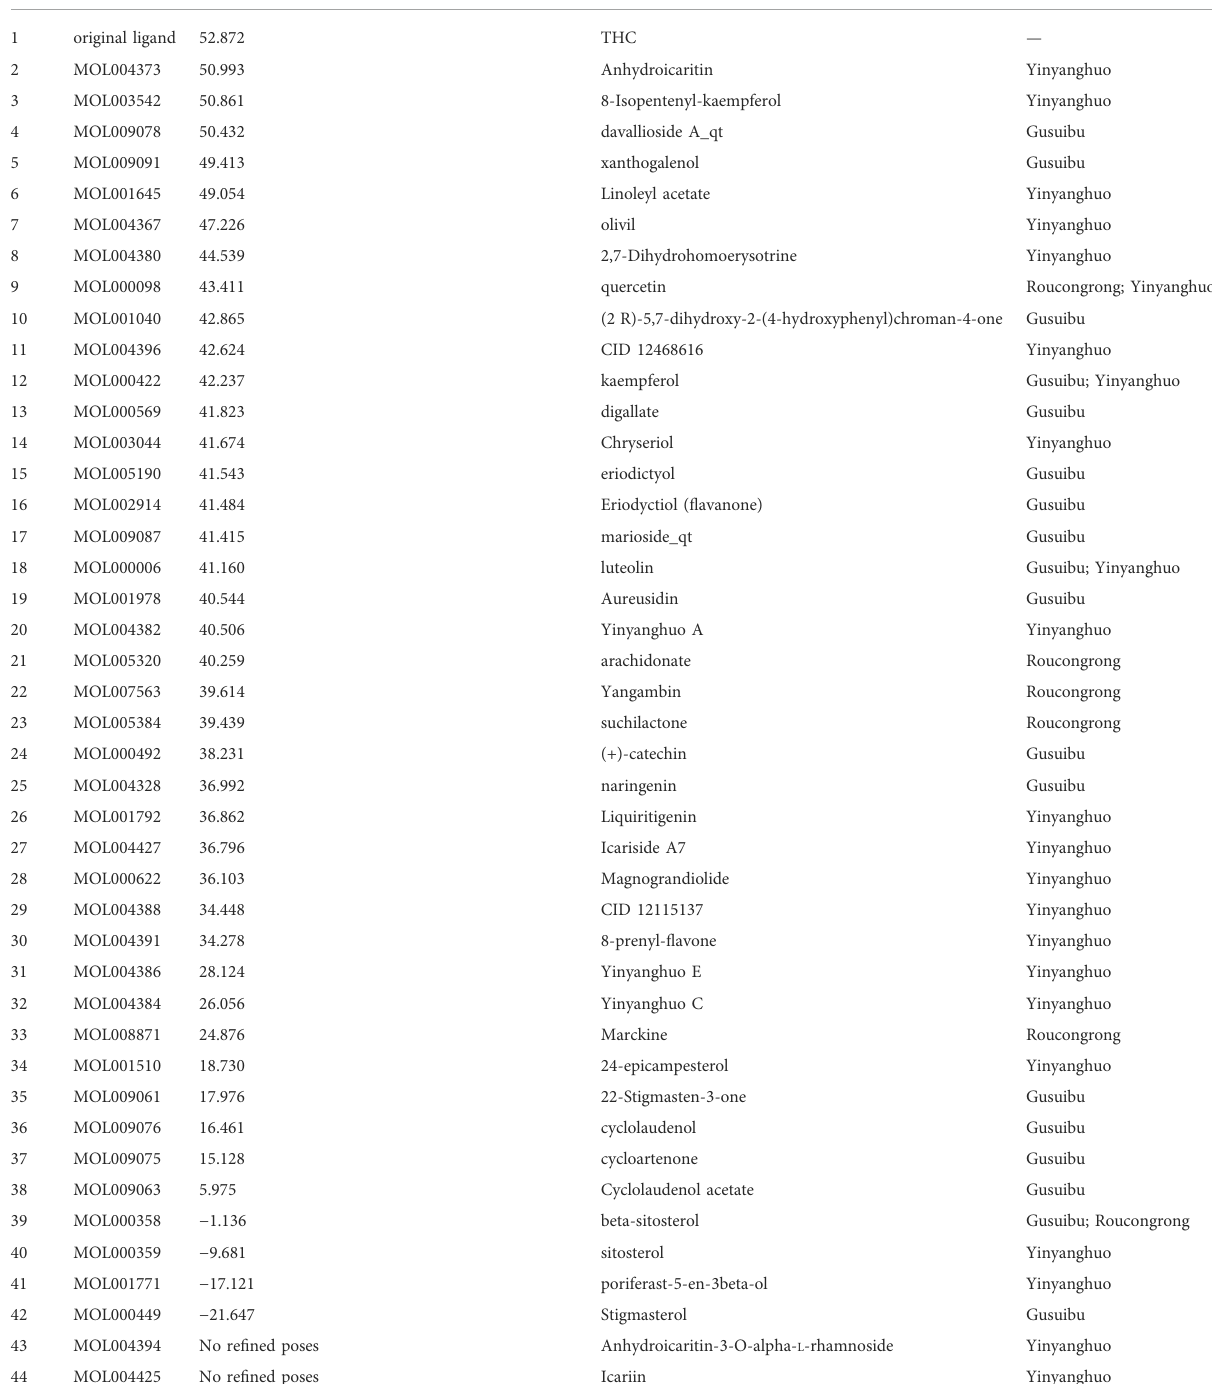
TABLE 5 ESR2 molecular docking